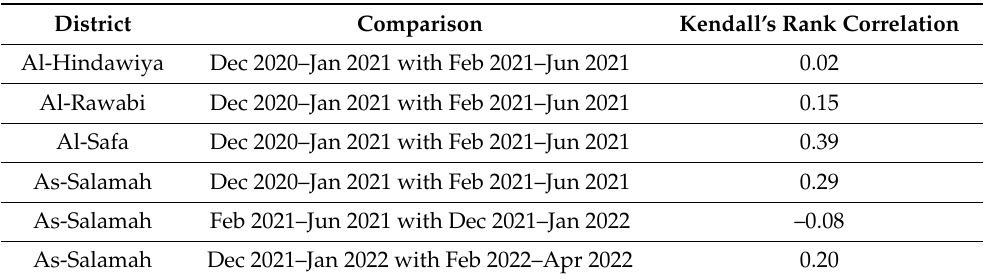
Table A7. Correlation in modelled mosquito presence surfaces for trap collection locations. District